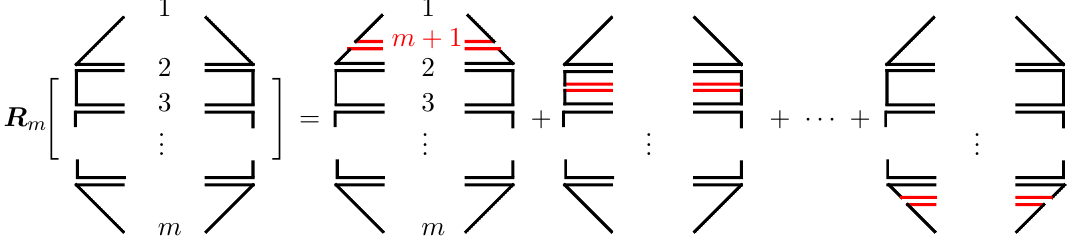
Figure 2 . The action of the operator R m on an amplitude with m legs in the large- N c limit. The double and single lines represent gluons and quarks,